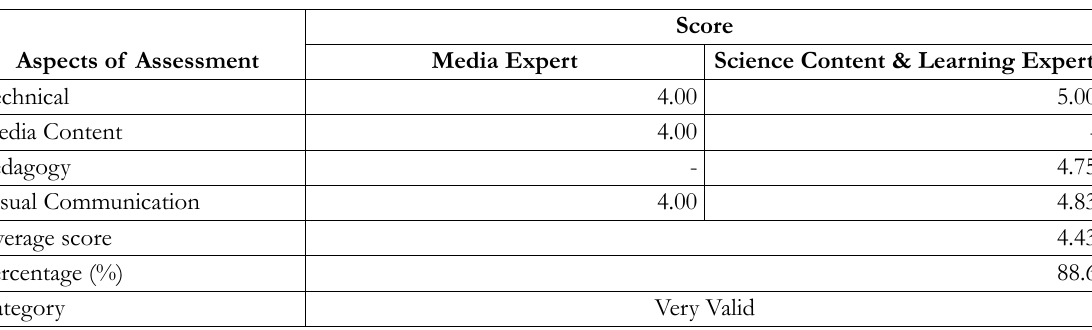
Table 2. Virtual Garden Content and Media Validation